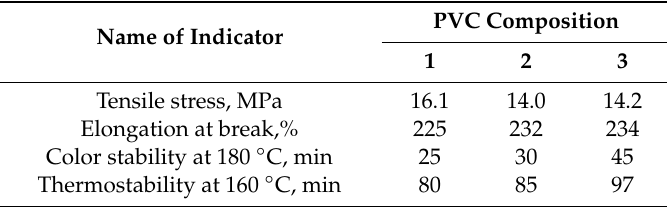
Table 6. PVC composition test